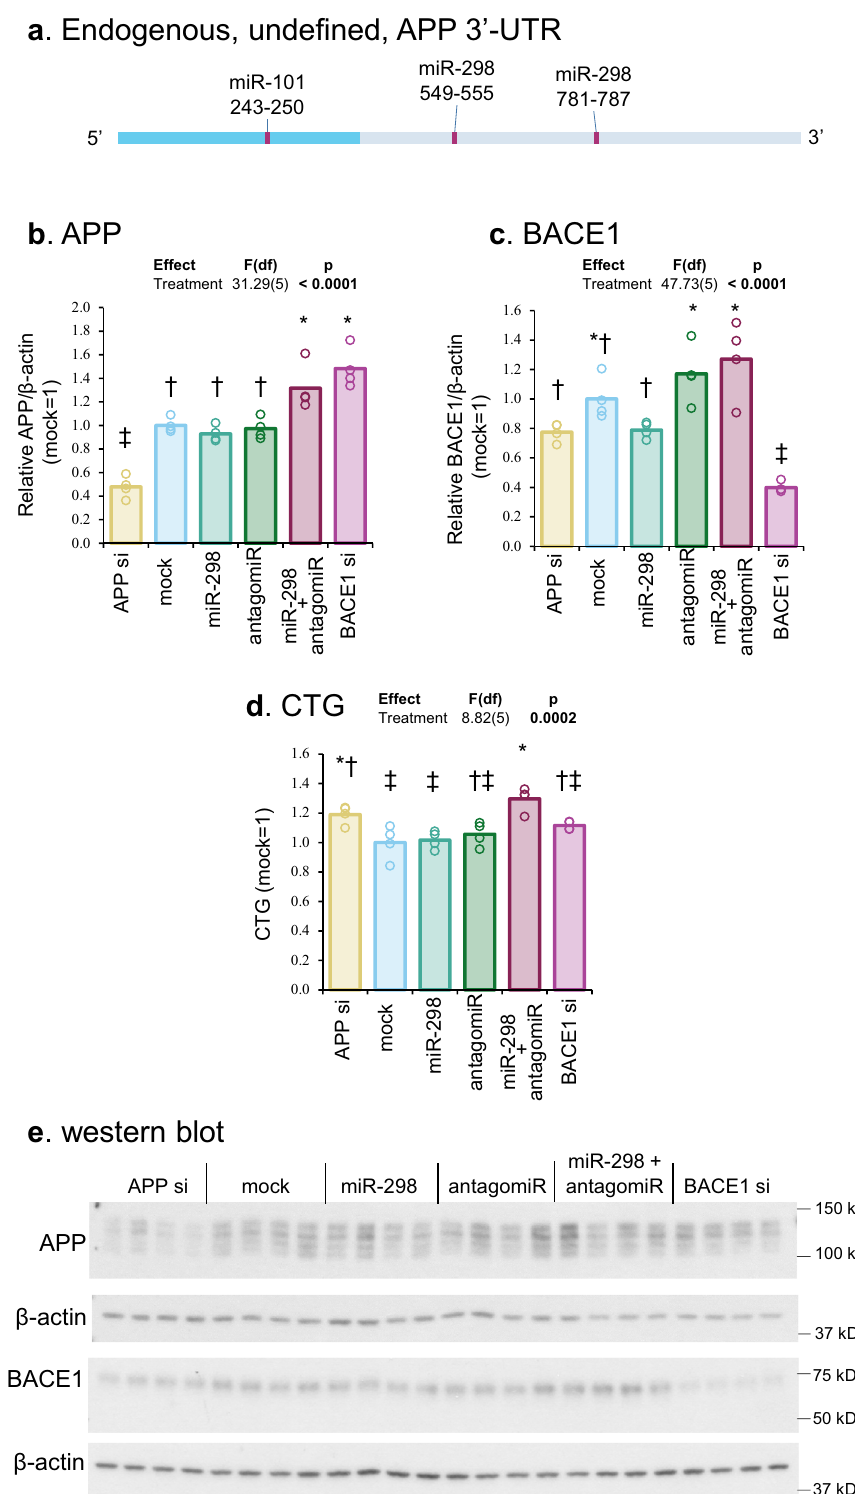
Figure 4. Effects of miR-298 on endogenous APP levels in differentiated neuroblastoma cells. ( a ) Scale drawing of endogenous APP mRNA undefined 3 ′ -UTR with miR-101 and miR-298 binding sites. Dashed line represents potential truncation or alternation of APP 3 ′ -UTR, where miR-298 binding sites could be absent. ( b , c ) Densitometric analysis of the blot. ( d ) Cell viability analysis by CTG assay. ( e ) Western blotting of APP, BACE1 and β-actin protein. Results of pairwise comparison of all treatments is shown by symbols. Treatments sharing a symbol did not significantly differ (p < 0.05). "(ns)" indicates no significant pairwise